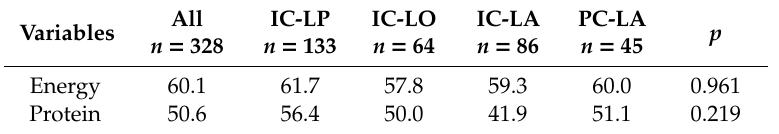
Table A2. Proportion of Participants Not Meeting Recommendations for Energy and Protein